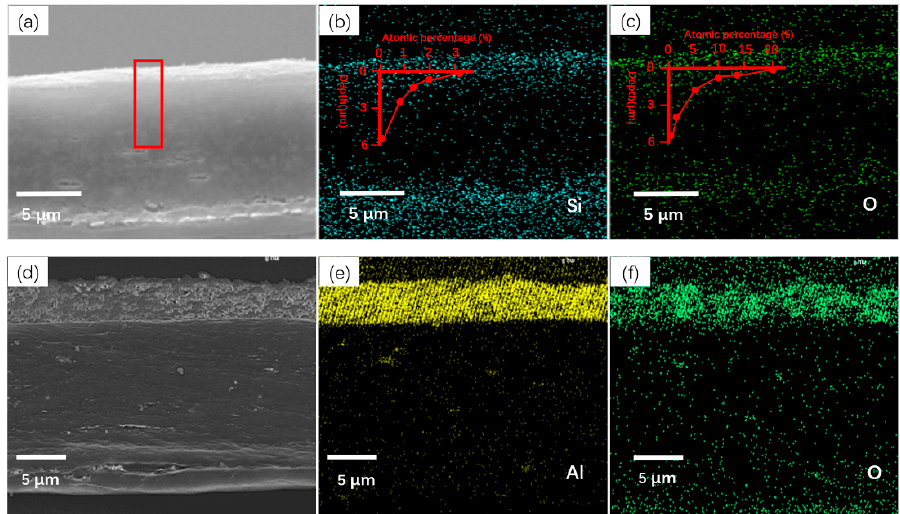
Figure 3. ( a ) Cross-section SEM image of SiO 2.01 C 0.23 H x -coated PE separator; ( b ) and ( c ) are corresponding energy dispersive X-ray spectroscopy (EDS) maps of the Si and O, respectively; ( d ) cross-section SEM image of Al 2 O 3 particle-coated PE separator; ( e ) and ( f ) are corresponding EDS maps of the Al and O, respectively.